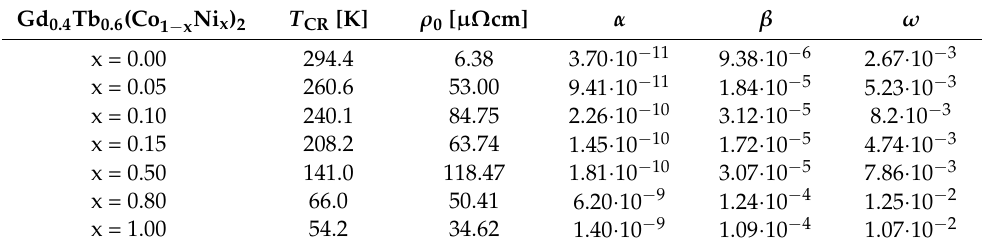
Table 4. The Curie temperatures T CR from resistivity measurements, residual resistivity ρ 0 , and fitting parameters from the Equation